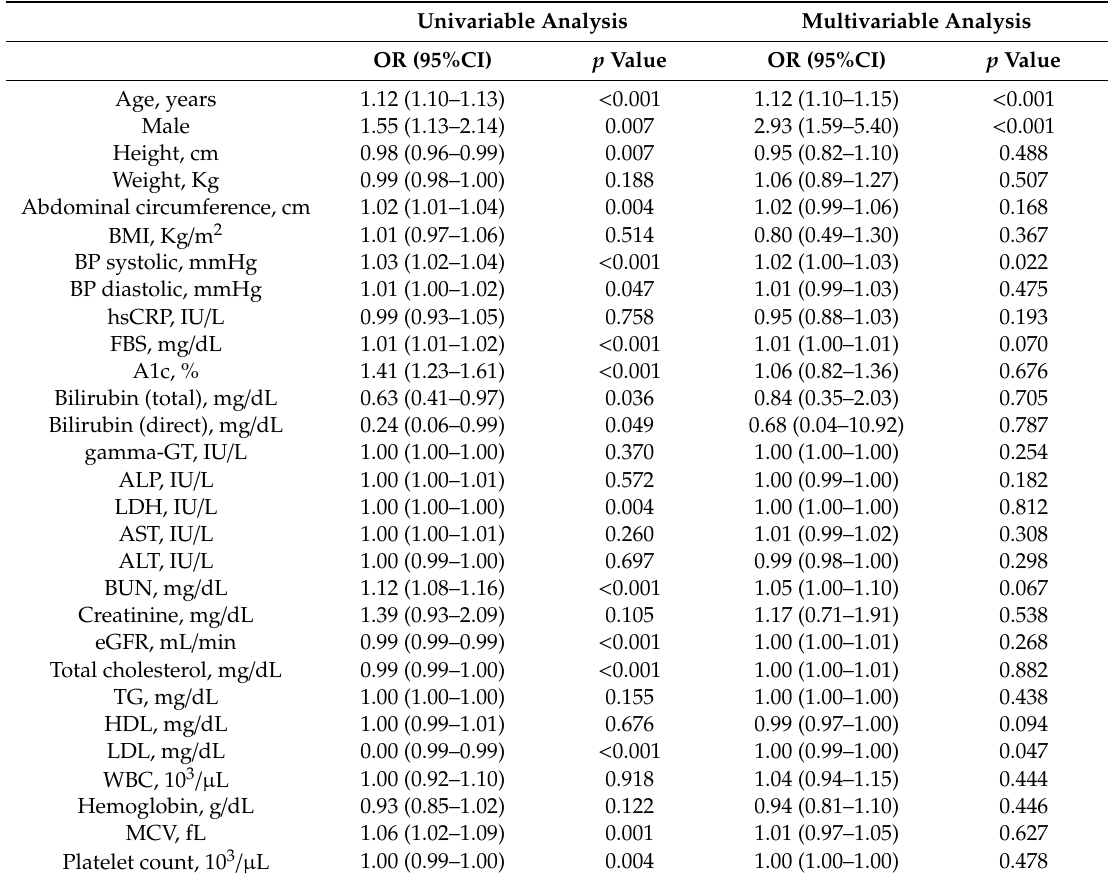
Table 2. Results of the binary logistic regression analysis to predict high coronary artery calcium score in the entire study population ( N =